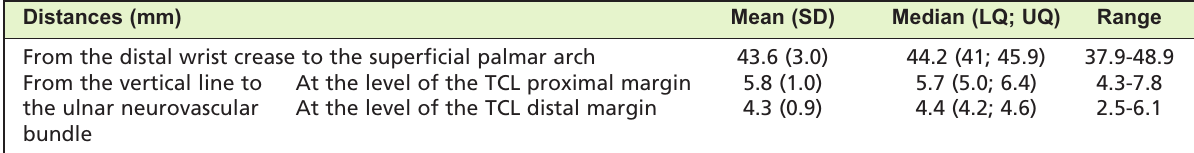
Distances between the distal wrist crease to the superficial palmar arch and between the vertical line to the Table II: ulnar neurovascular bundle Distances (mm)